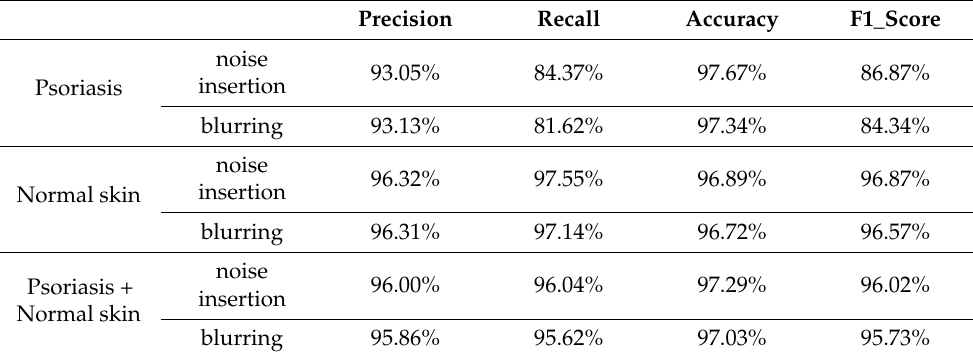
Table 2. Experimental results of the proposed scheme for robustness